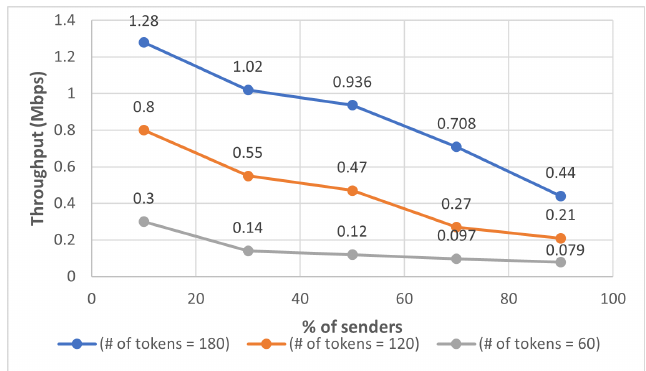
Figure 12. Throughput vs. percentage of senders in Ring2Tor .